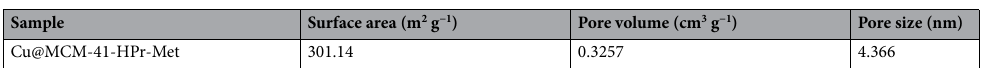
Table 1. Surface area, pore volume, and pore diameter of Cu@MCM-41-HPr-Met.